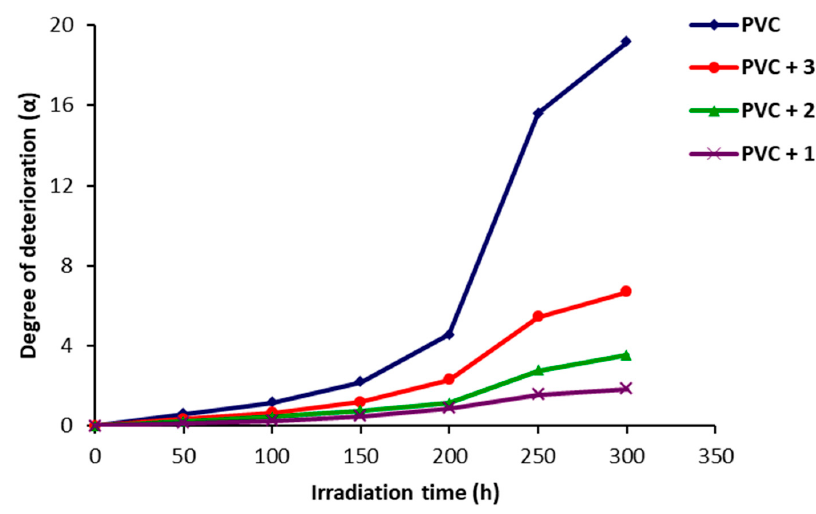
Figure 9. Effect of irradiation of PVC films on α .